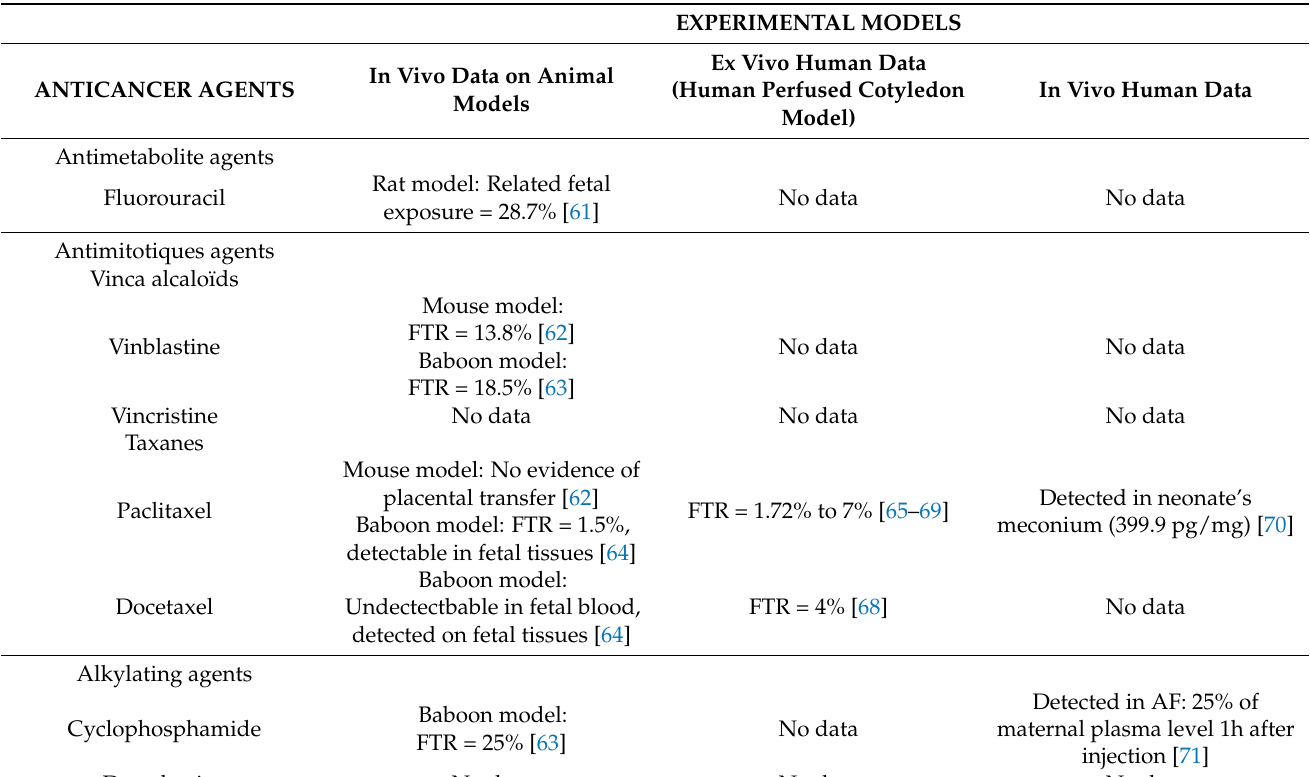
Table 1. Overview of transplacental transfer of anticancer